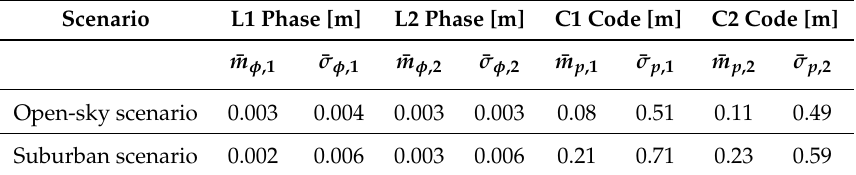
Table 4. Overbounding mean values ( ¯ m φ , j , ¯ m p , j ) and standard deviations (¯ σ φ , j , ¯ σ p , j ) for the